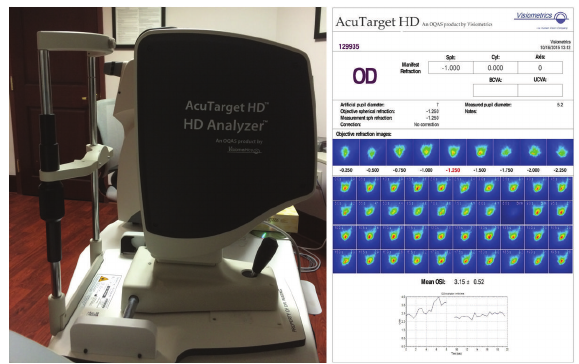
Figure 1: The AcuTarget HD and representation of objective scatter index and tear film analysis.